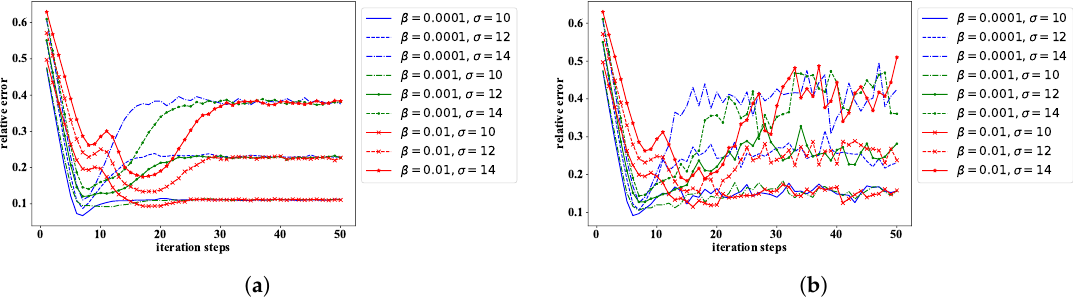
Figure 3. The relative error of different β 0 with different conductivities: ( a ) when SNR = 40 dB and ( b ) when SNR = 20